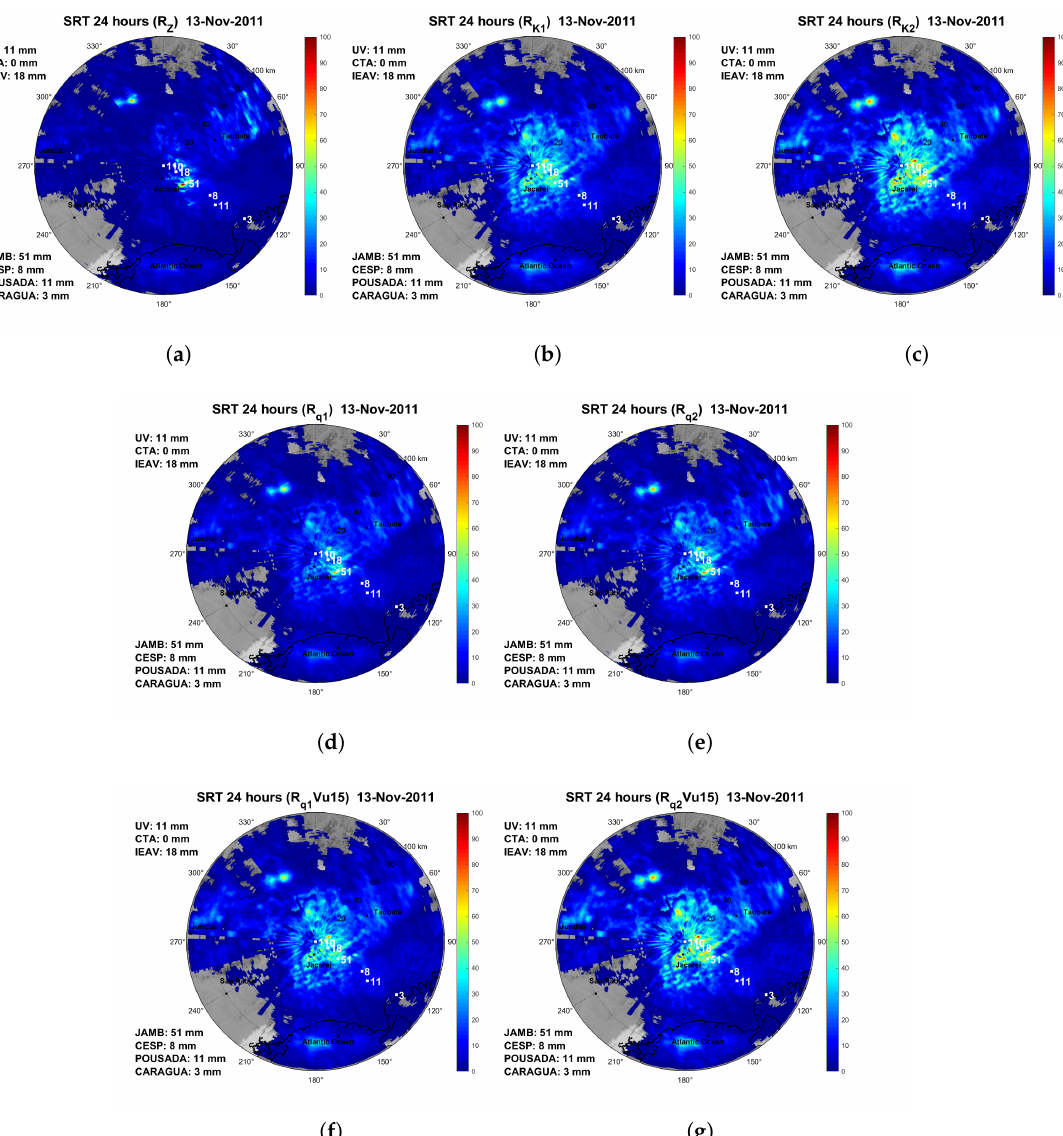
Figure 8. Surface Rainfall Total (SRT) 24 hourly accumulated using ( a ) R Z model, ( b ) R K 1 model, ( c ) R K 2 model, ( d ) R q 1 model, ( e ) R q 2 model, ( f ) R q 1 Vu 15 model and ( g ) R q 2 Vu 15 model for the event which occurred on 13 November 2011. The corresponding values accumulated by the rain gauges are shown in the